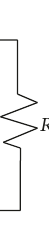
Figure 4: Modified Fricke model.